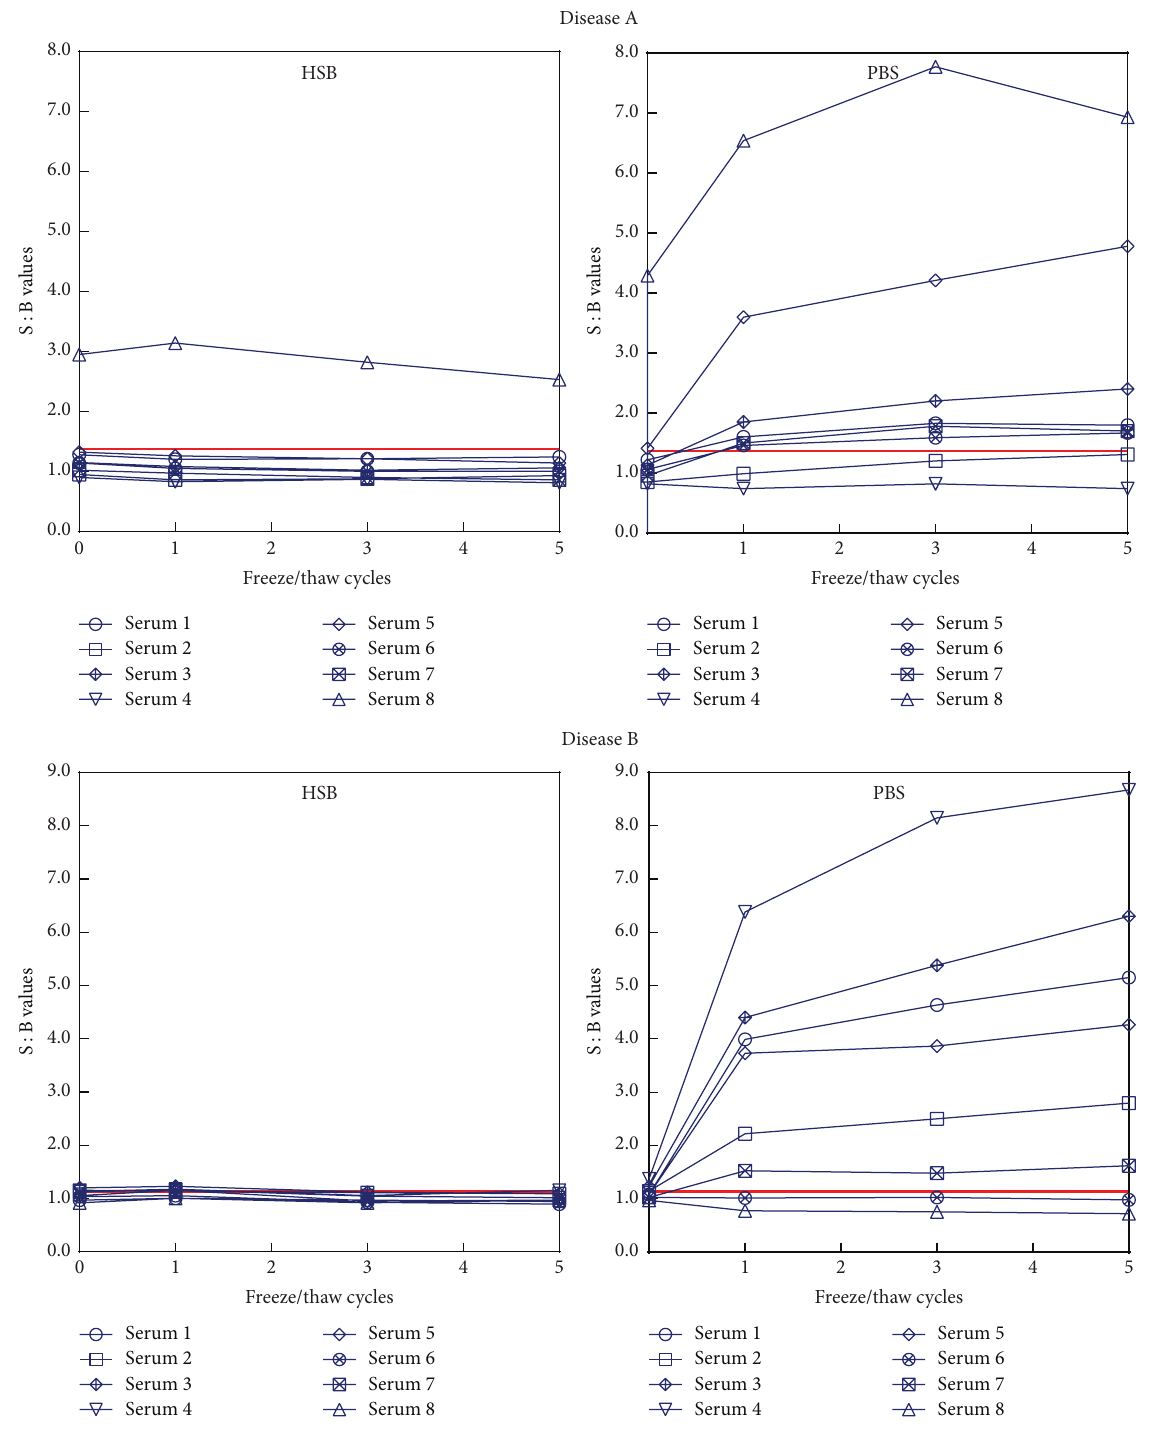
Figure 2: Screening responses of individual disease A and disease B serum samples tested using ruthenylated antibody reagents stored in PBS and in HSB. The solid red line on each graph indicates screening cut point values for disease A (1.37) and disease B (1.14) populations obtained during method